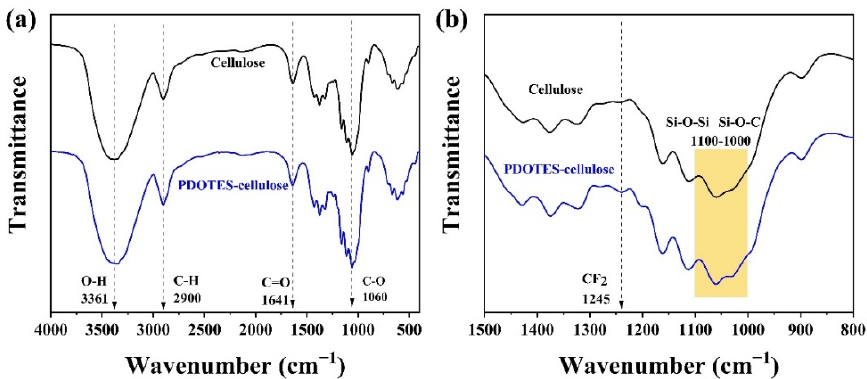
Figure 3. FTIR spectra of cellulose before and after modification: ( a ) 4000–500 cm − 1 ; ( b )1500–800 cm − 1 .